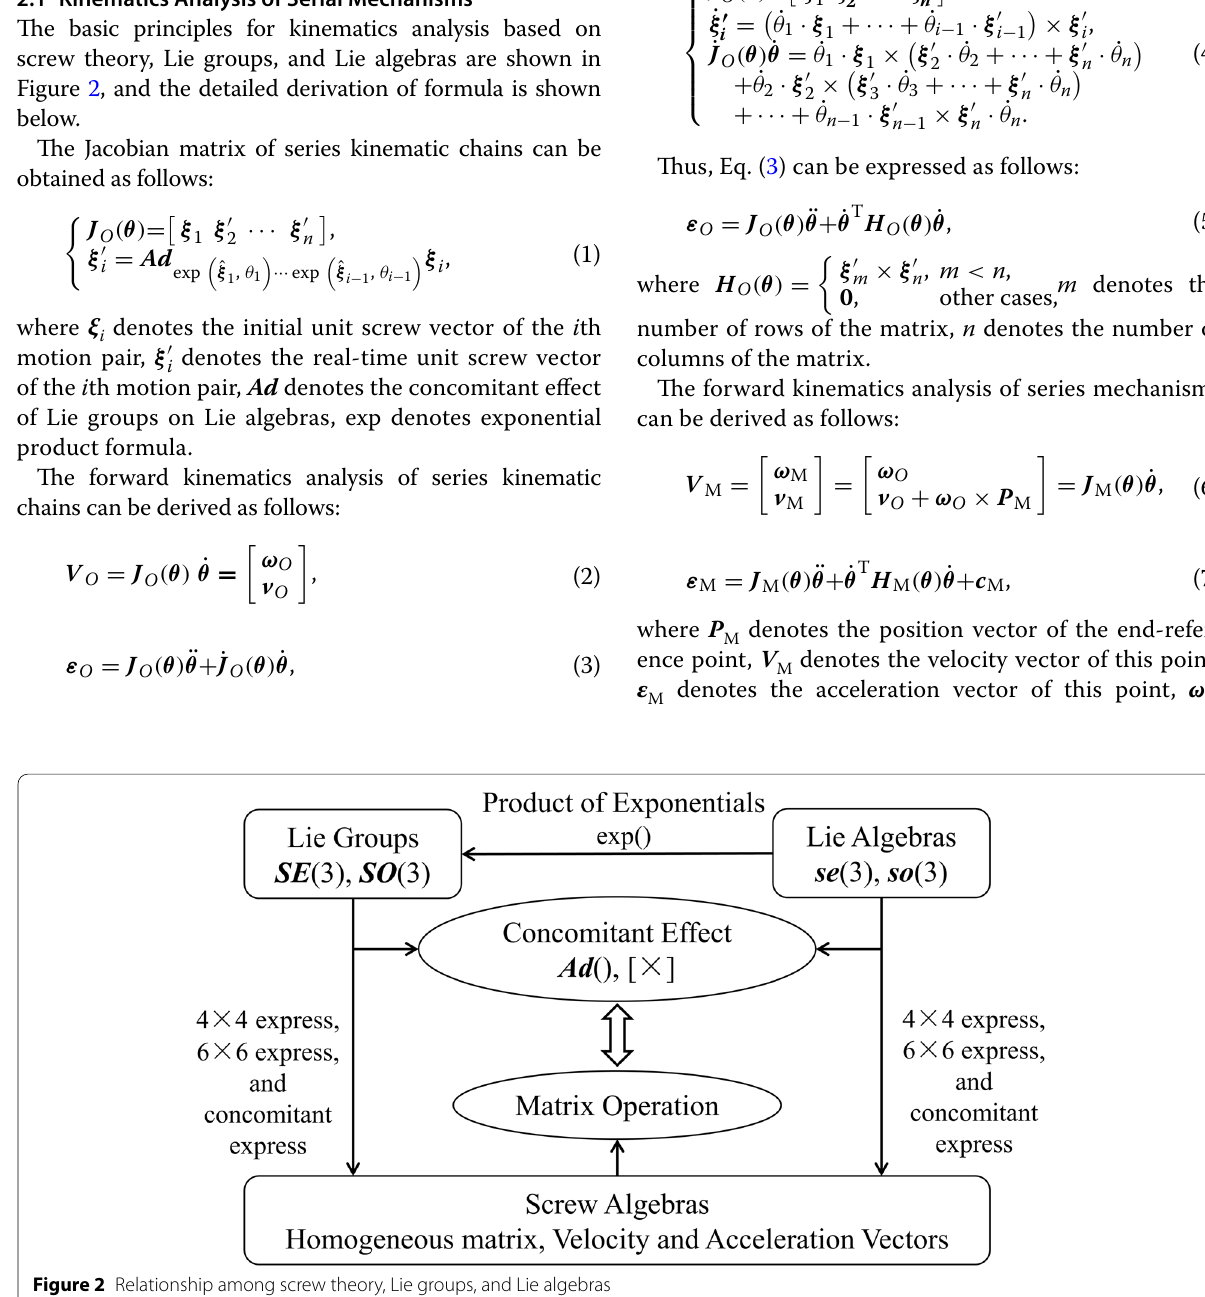
Figure 2 Relationship among screw theory, Lie groups, and Lie